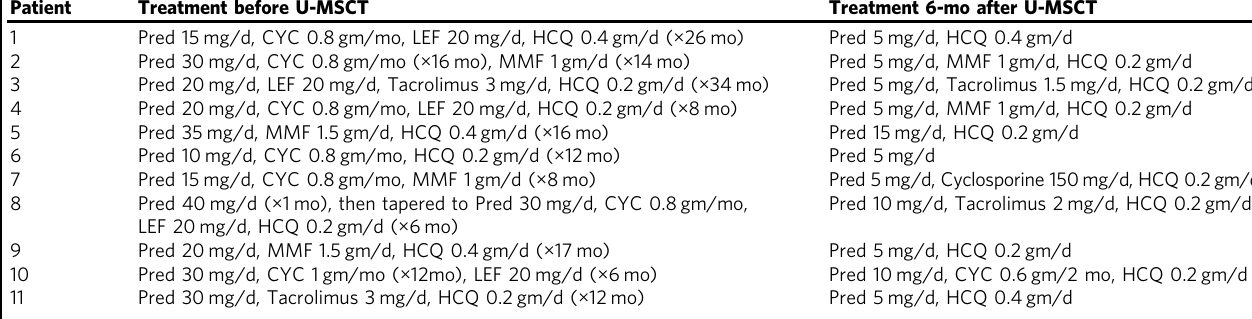
Table 2 Patients ’ treatment before and after U-MSCT Patient Treatment before U-MSCT Treatment 6-mo after